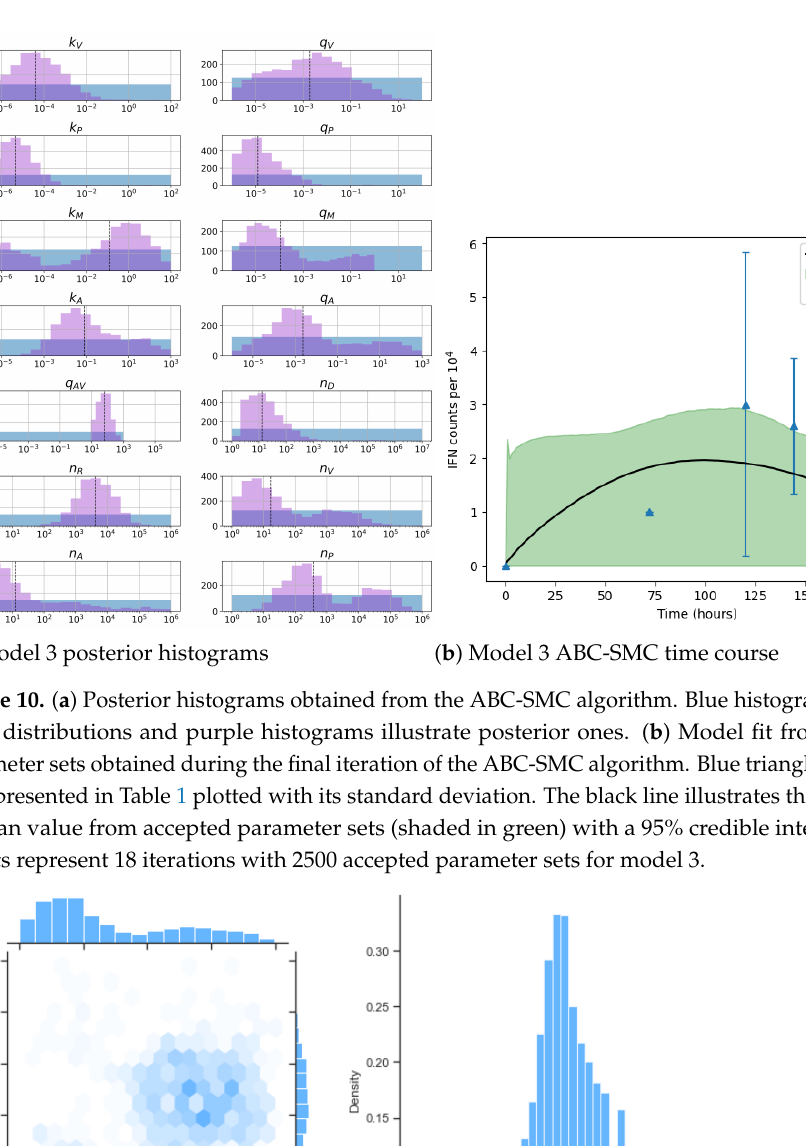
Figure 11. Left: bivariate posterior histogram of log tion ( r = 0.60). Right: Posterior distribution of the ratio log ( q M / n V )